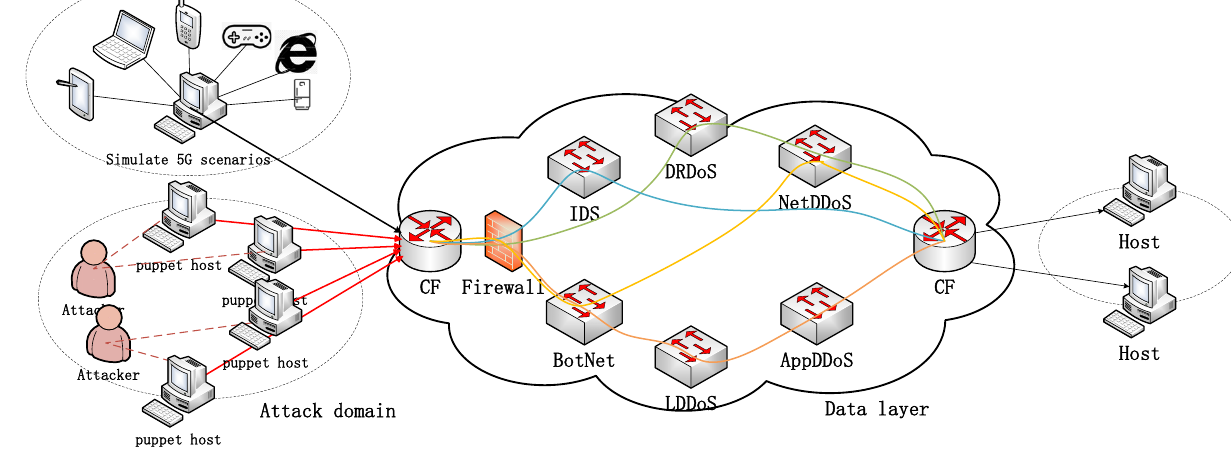
Figure 10. Data Layer Security Function Dynamic Deployment Experimental Topology. Table 4. Type of attack.